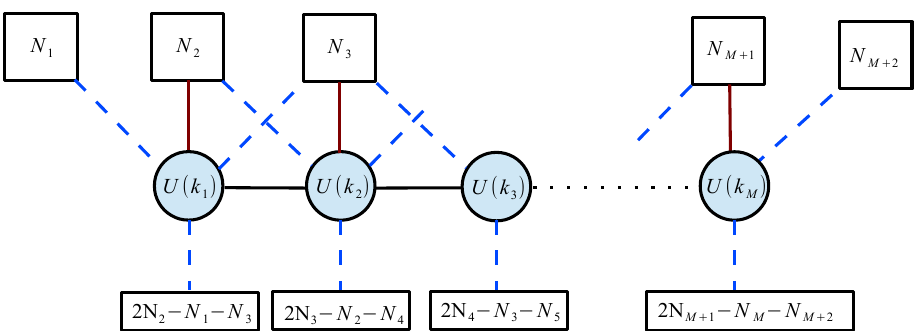
Figure 2 . Convex chain of (cid:0) 2